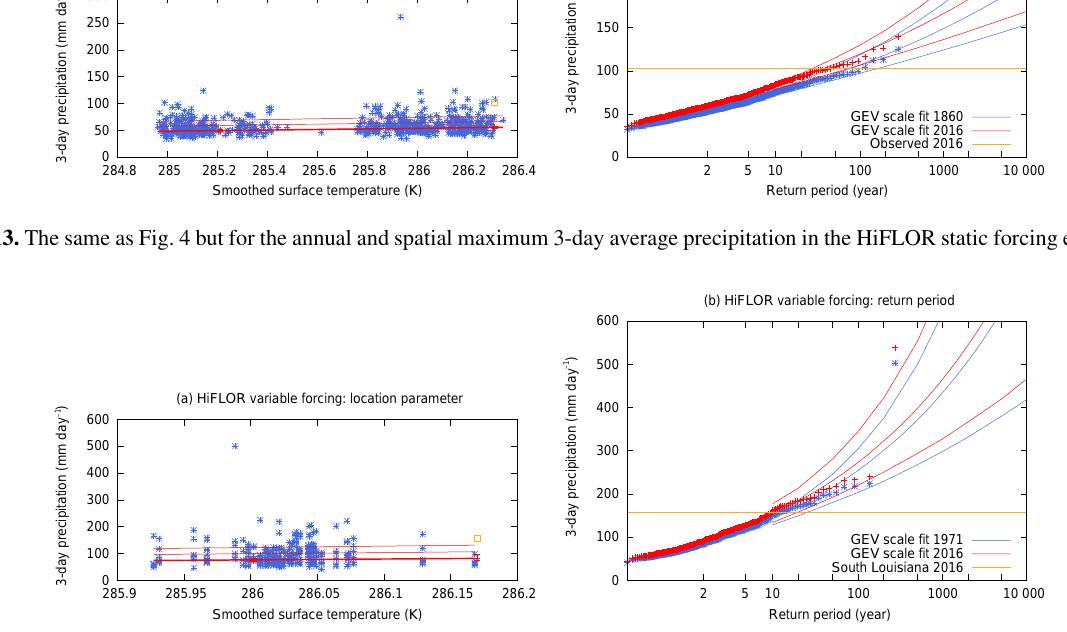
Figure 14. The same as Fig. 4 but for the annual and spatial maximum 3-day average precipitation in the HiFLOR variable forcing restored SST